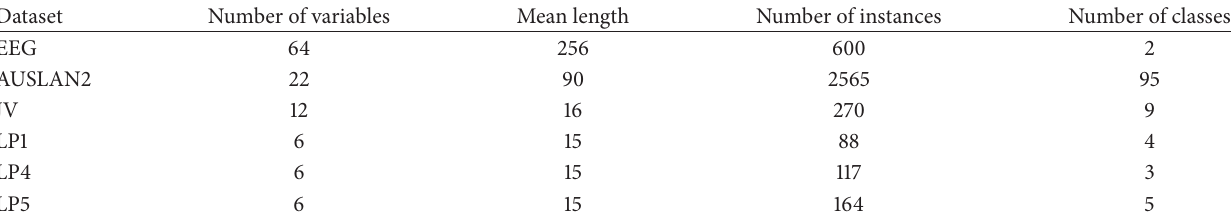
Table 1: Summary of datasets used in the